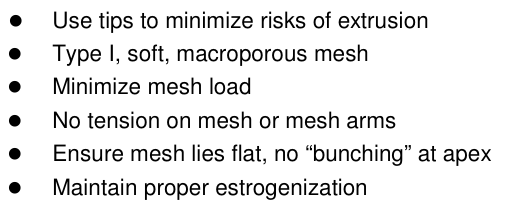
Minimizing Risks of Dyspareunia